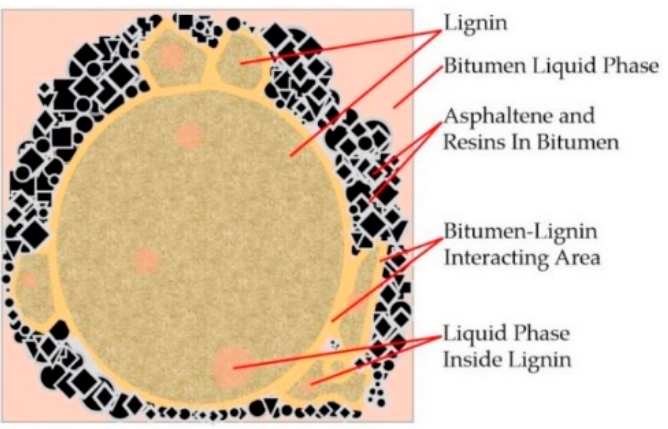
Figure 9. Schematic diagram of the mechanism of the asphalt–lignin working system [41].